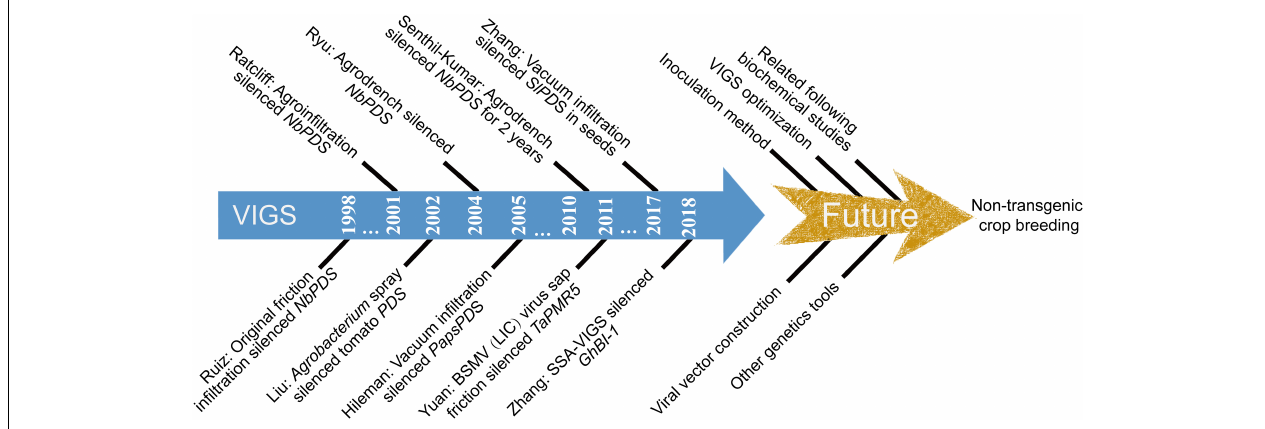
FIGURE 4 | Important historical milestones of VIGS system. TRV: Tobacco rattle virus; BSMV: Barley stripe mosaic virus; LIC: Ligation-independent cloning; SSA-VIGS: Seed sock agroinoculation VIGS; NbPDS: Tobacco phytoene desaturase; TaPMR5: Wheat powdery mildew resistance 5 gene; SlPDS: Tomato phytoene desaturase; GhBI-1: Cotton Bax